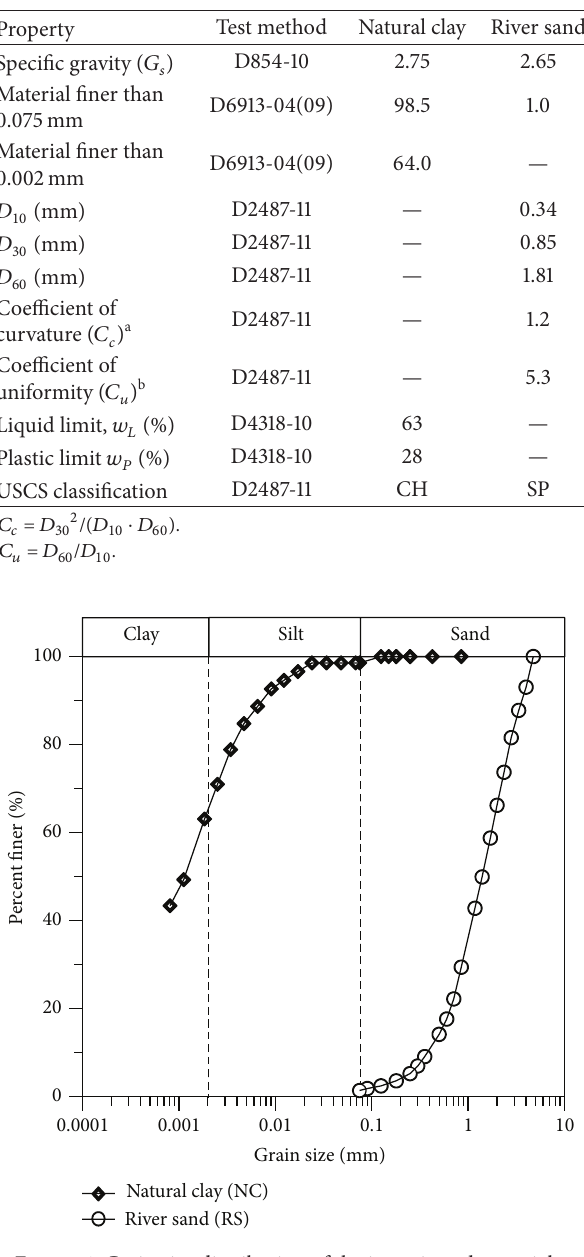
Figure 1: Grain size distribution of the investigated